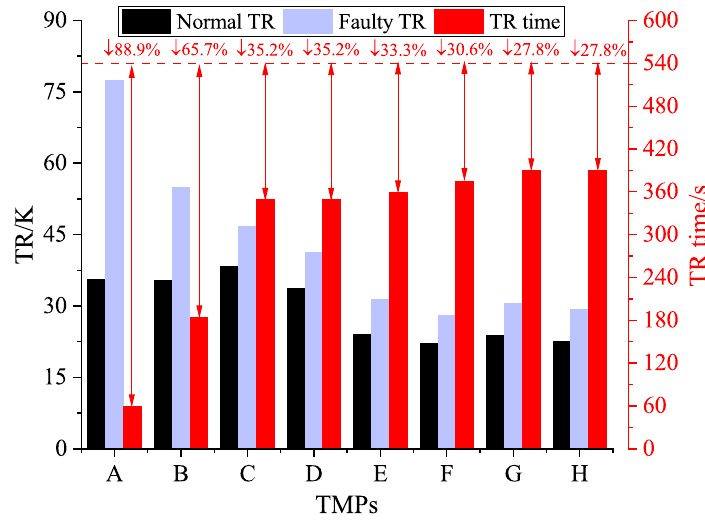
Figure 11. Variation of TR and TR time at each TMP. According to the analysis results in the previous section, the temperature characteris- tics of the motor housing, stator core, and rotor are not obvious after the fault; on the other hand, the part with the most drastic temperature change is the stator winding. Figure 12 shows the temperature distribution of stator winding at three different moments. The posi- tions of each slot, phase belt, and the faulty slot are marked in the figure. It can be seen that the temperature distribution of normal motor windings is evenly distributed in the initial stage, middle stage, and steady state of operation, and the temperature difference between windings in different slots is small. The distribution of winding temperature after the fault is complex. The temperature of non-faulty phase winding shown in Figure 12a is almost the same as that of the normal motor in the initial stage of faulty operation, while the temperature of the faulty phase winding increases significantly and the temperature of the faulty slot winding is the highest. From the middle stage of faulty operation to the final moment, the winding temperature of the faulty phase continues to rise, the temperature distribution remains unchanged, and the temperature of non-faulty winding also gradually increases, which is significantly higher than the temperature of the normal motor.